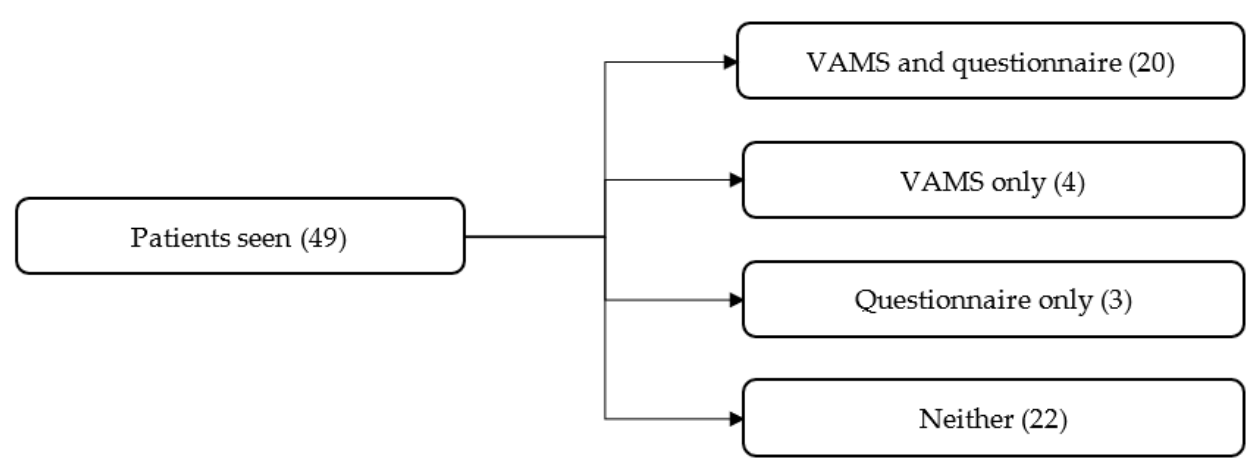
Figure 1. Patient participation in Visual Analog Mood Scale (VAMS) and questionnaire feedback. Table 1. Patient demographic and diagnostic data, and referral reason and attendance at Neurologic Music Therapy (NMT).